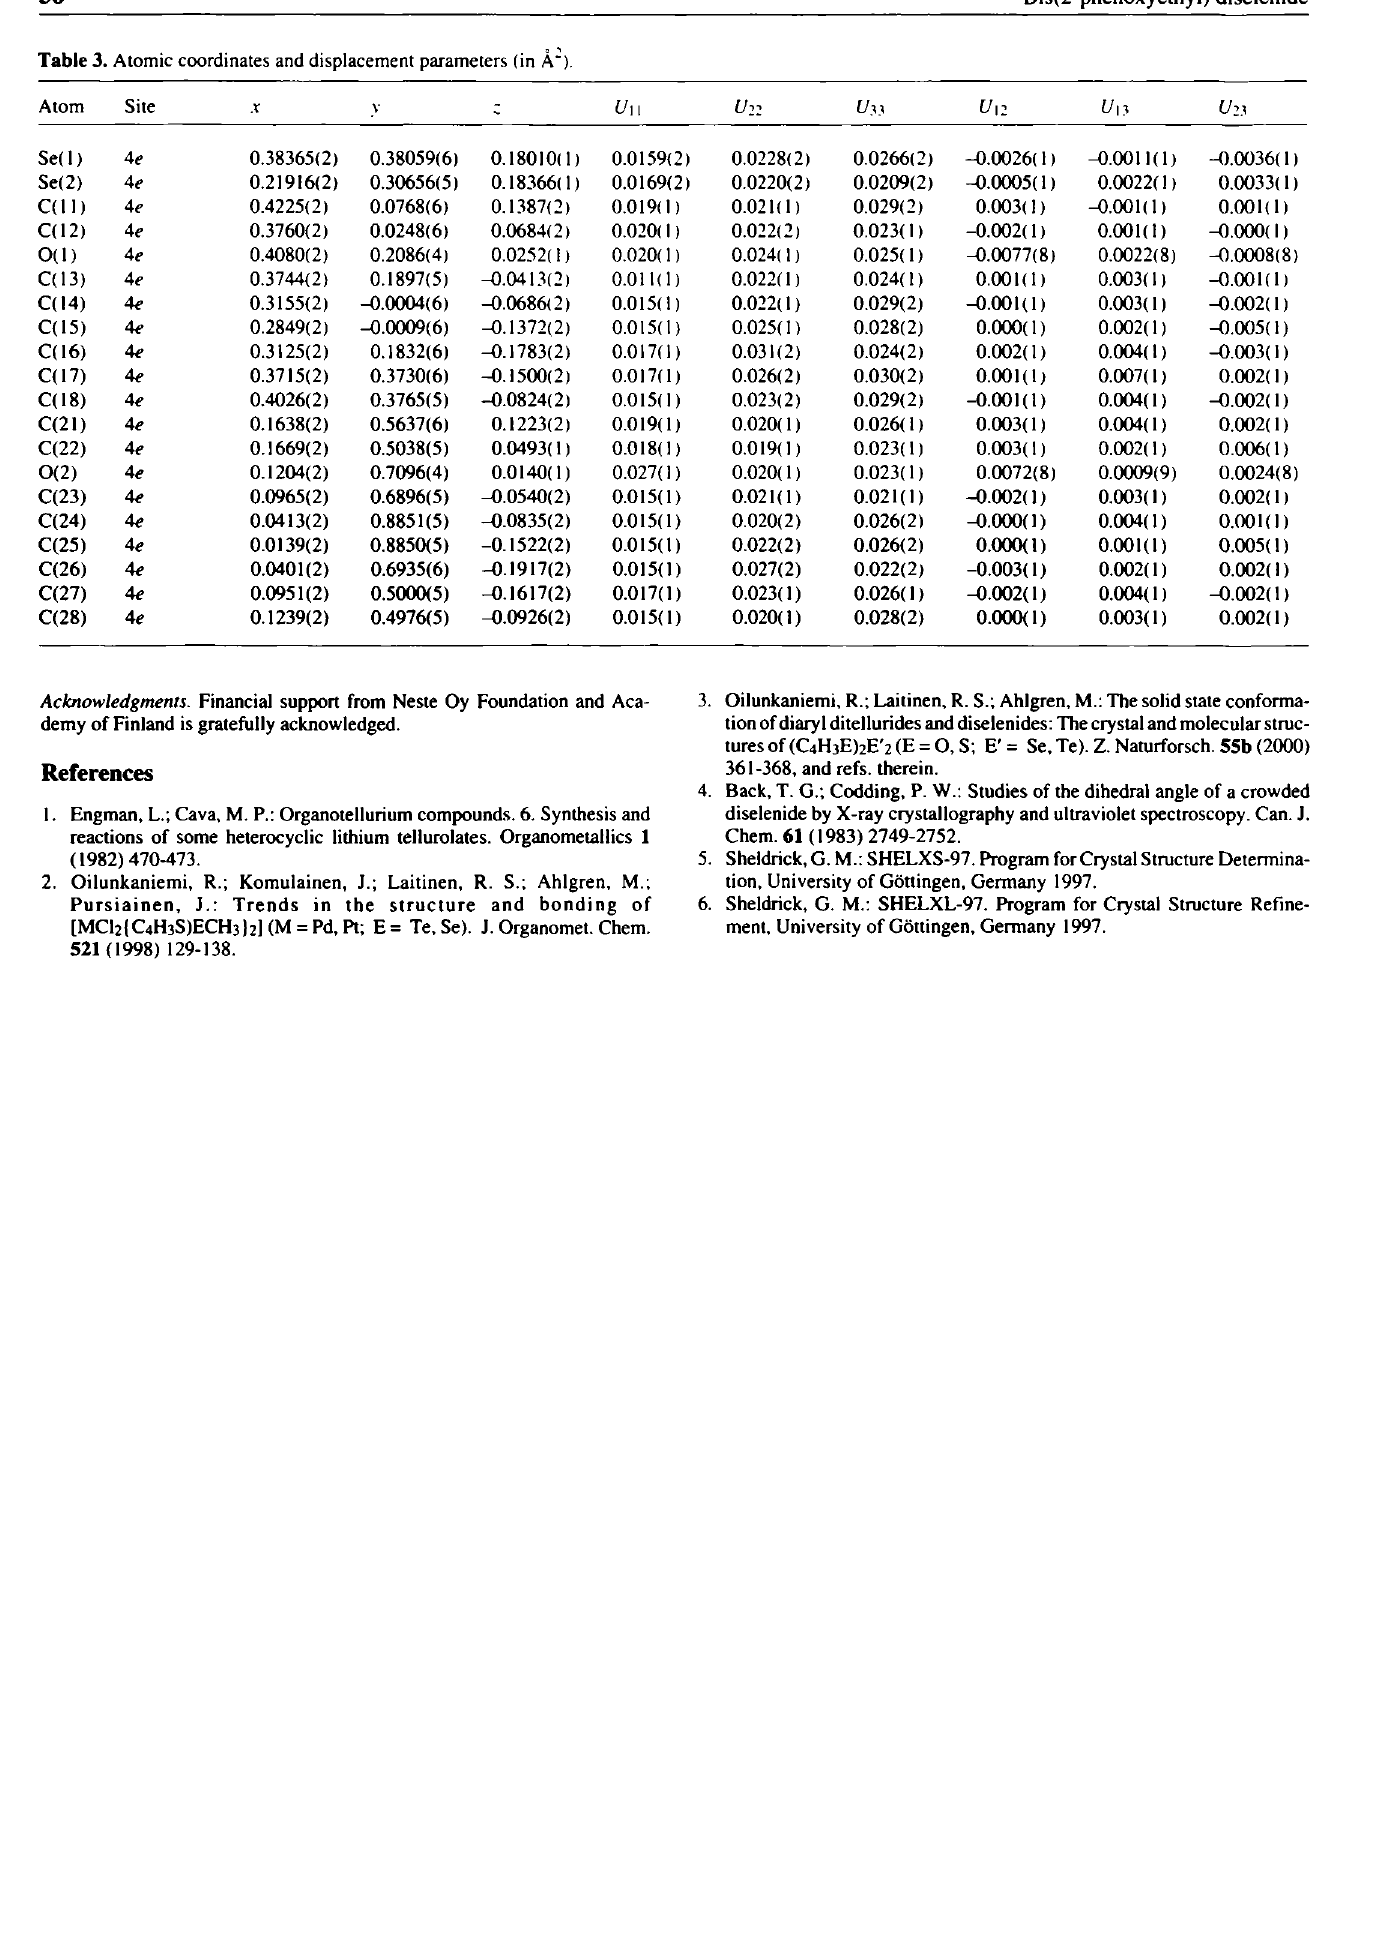
Table 3. Atomic coordinates and displacement parameters (in